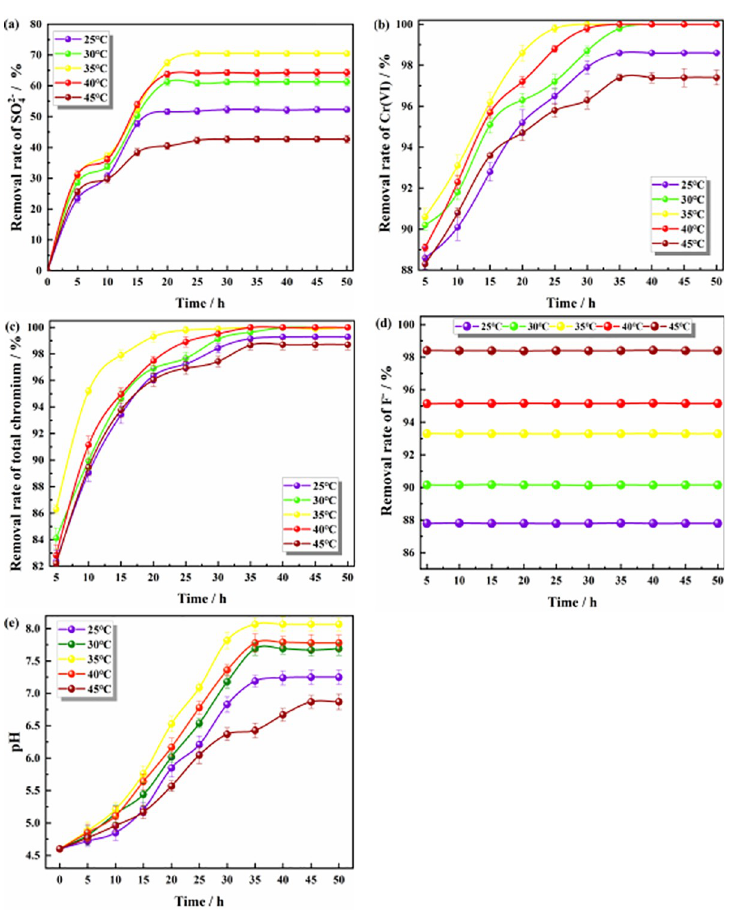
Fig 5. Effect of the reaction temperature on pollutants. (a) The effect on the removal of SO 42- ; (b) The effect on the removal of Cr(VI); (c) The effect on the removal of total chromium; (d) The effect on the removal of F - ; (e) The effect on pH